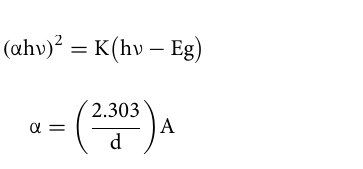
Figure 5. ( a ) The effect of light power density on the produced J ph from − 1 to + 1 V and ( b ) the relation between the light power and the produced J ph at + 1.0